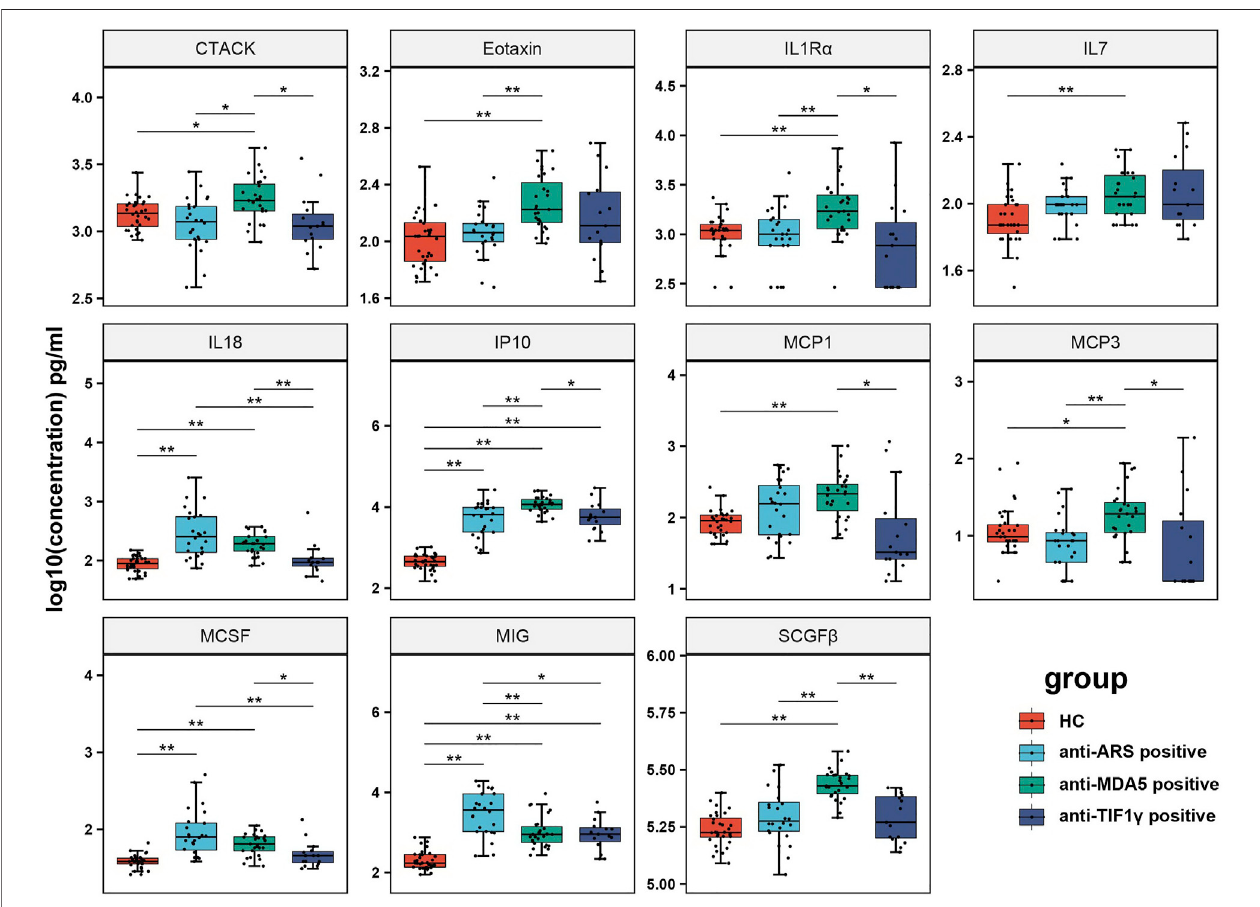
FIGURE 2 | Comparison of cytokines among anti-ARS positive, anti-MDA5 positive, anti-TIF1 γ positive IIMs patients and HC. The Human 48-Plex Luminex assay for cytokines was performed in the serum of different MSAsIIMs groups (24 anti-ARS positive, 27 anti-MDA5 positive, 15 anti-TIF1 γ positive). Mann-Whitney U test was used to compare the marked groups ( p -values were adjusted using the “ Bonferroni ” method during the multiple comparisons test). * p < 0.05 and ** p < 0.01.